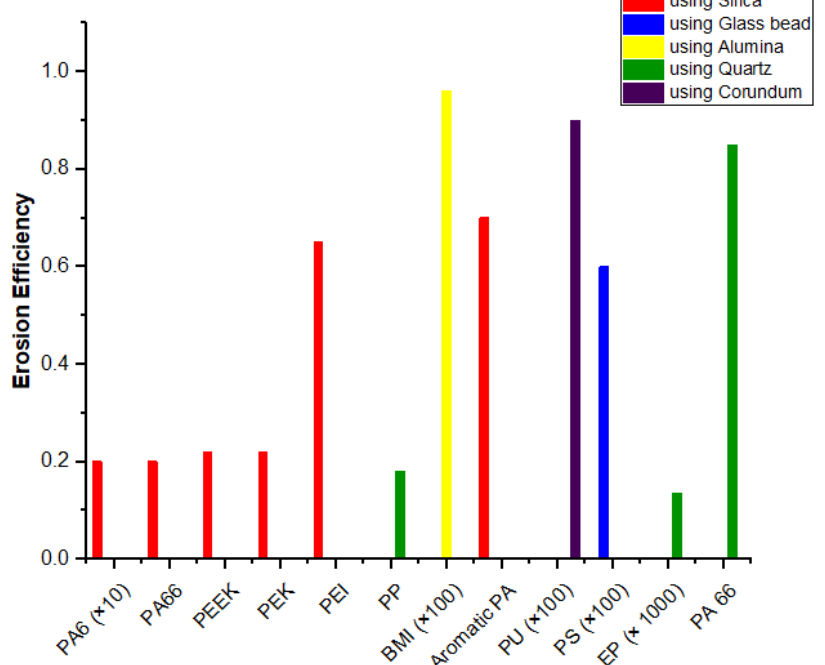
Figure 4. Minimum reported erosion efficiencies of neat polymers at optimized impact velocity using different erodents [15,24].